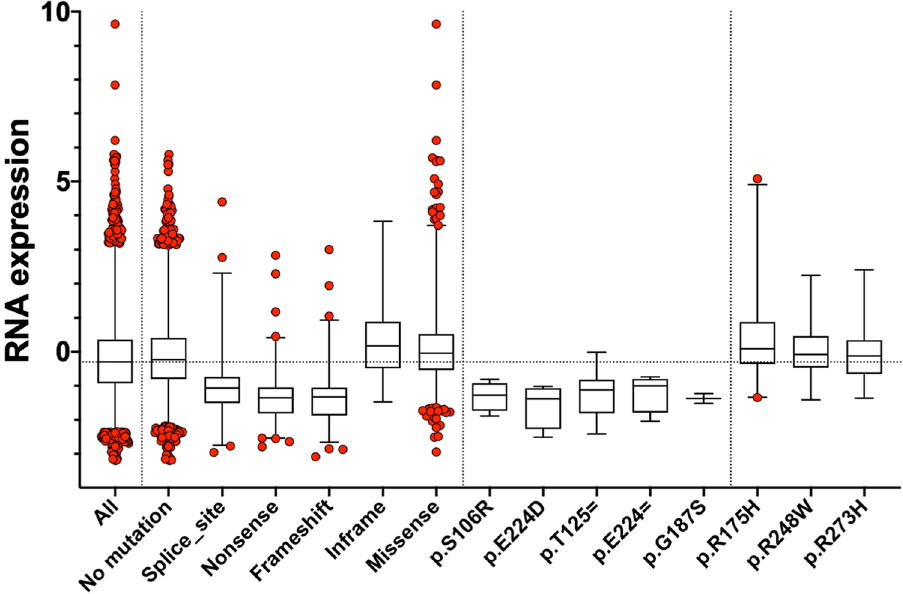
Figure 6. TP53 RNA expression differs in tumors depending on TP53 mutation status. Box-and-whisker plots show the interquartile ranges (boxes), median values (horizontal lines inside the boxes), and full-range distributions (whisker lines) for TP53 RNA content according to the type of TP53 mutation. RNA expression and TP53 mutational status values for multiple tumor types were extracted from cBioPortal (see